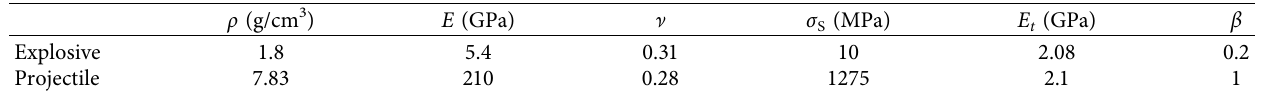
Figure 10: Simulation results. (a) Elements distribution; (b) axial stress curves for E1 and E1P; (c) axial stress curves for E2; (d) axial stress curves for E3; (e) axial stress curves for E4 and E4P; (f) separation between the explosive and the casing. Table 2: Material parameters of the explosive and the casing.